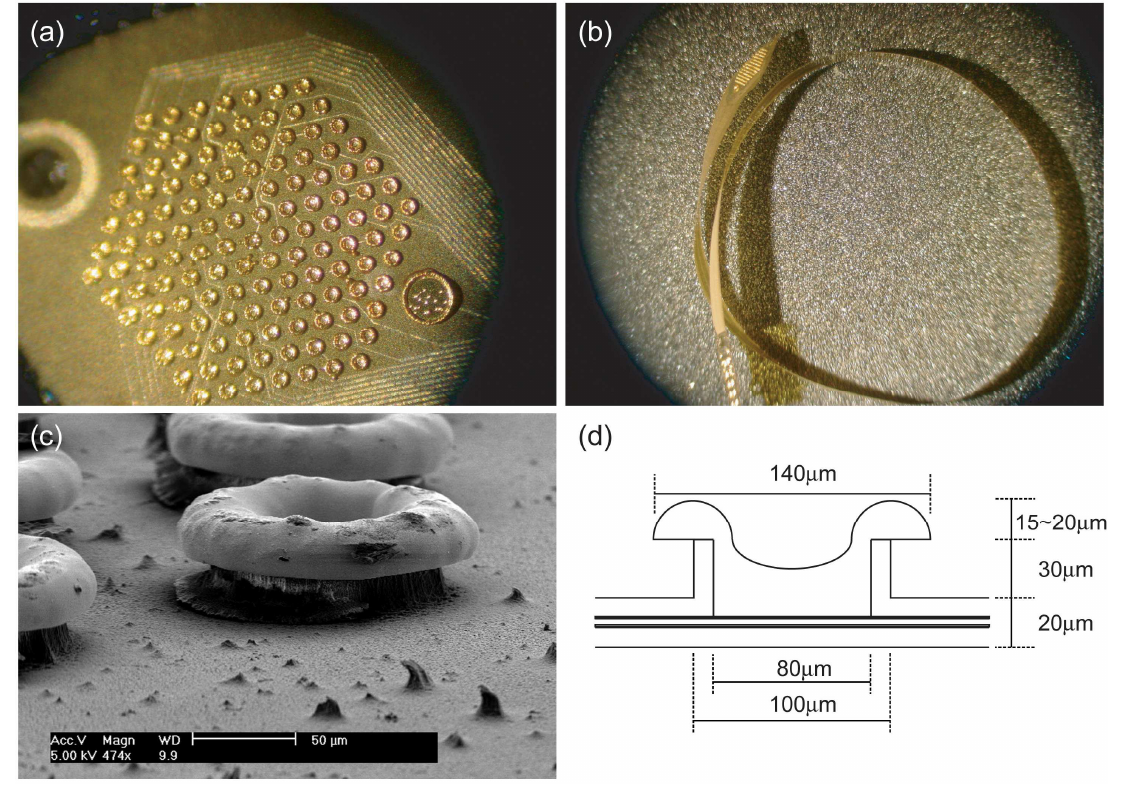
Figure 2 . Result of the proposed fabrication process. (a) Electrodes in the stimulation site (top view) and (b) the whole electrode array (side view). (c) Oblique view of pillar electrodes observed with the field emission scanning electron microscope. (d) Diagram of the manufactured pillar